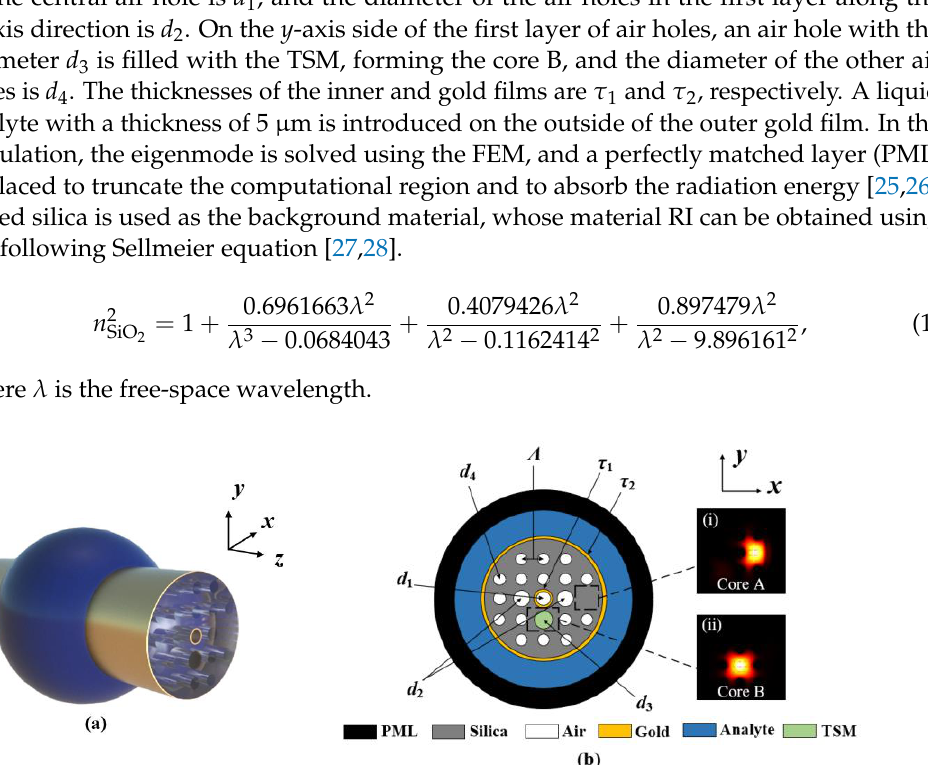
Figure 1. ( a ) The 3D view of the proposed SPR-based PCF sensor. ( b ) Cross-sectional schematic of the SPR-based PCF sensor. The inserts (i) and (ii) show the electric field distributions of the core A and B, respectively.